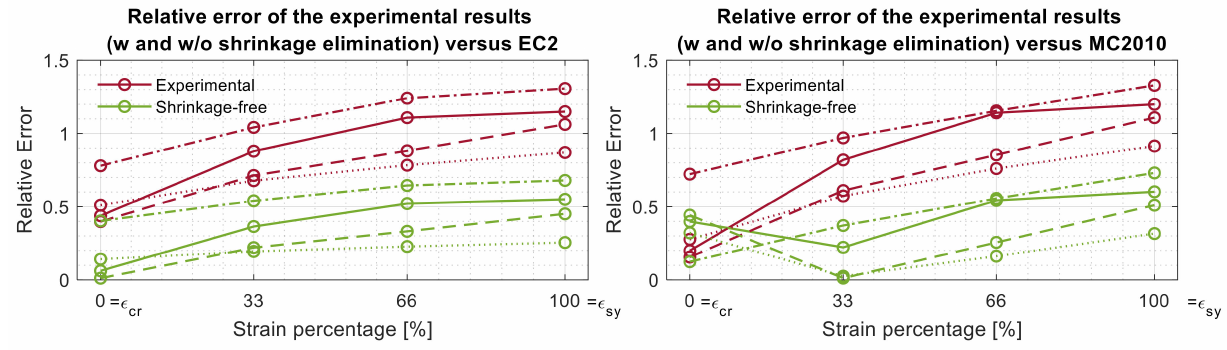
Figure 9. Relative errors of the experimental and shrinkage-free tension stiffening values of member T_12_500 versus the EC2 ( left ) and MC2010 ( right ) predictions.